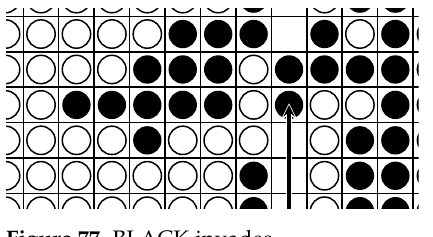
Figure 77. BLACK invades.